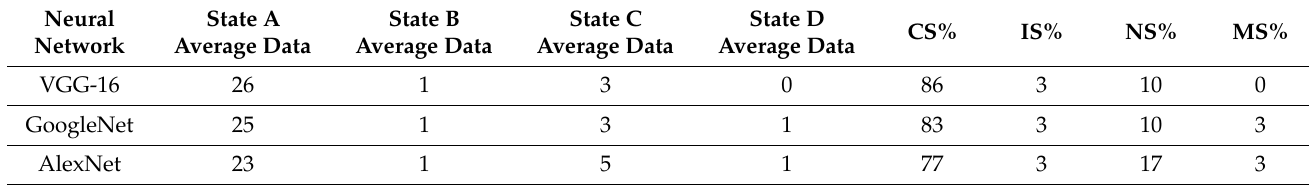
Table 6. Performance evaluation results of spraying system in field experiment.